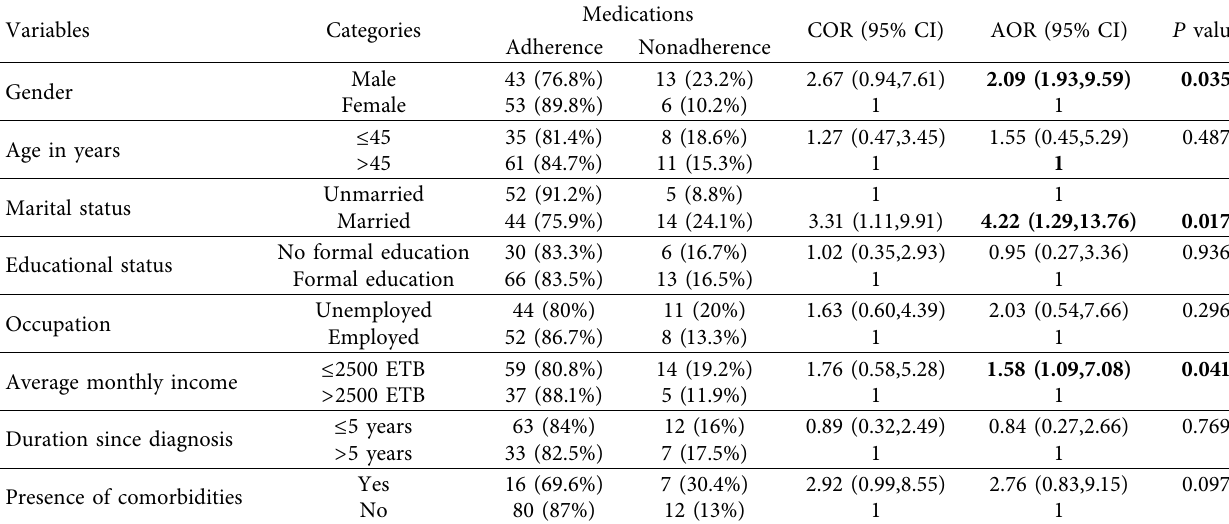
Table 8: Bivariable and multivariable analysis of factors associated with nonadherence to antihypertensive medications among hypertensive patients in a follow-up clinic at Asella Referral and Teaching Hospital, Asella Town, Arsi Zone, Oromia Regional State, Ethiopia, 2020 ( n �